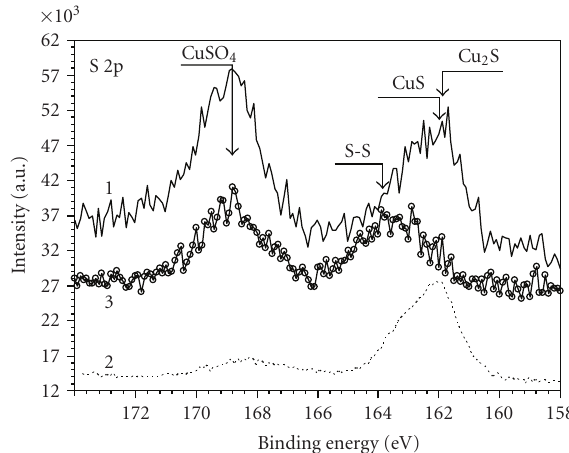
Figure 4: Sulfur XPS S 2p spectra of PA 6 sulfured for 5 hours and treated with Cu(I) salt: (1) before and (2) after Ar + cleaning, (3) sulfured PA 6 (for 4 hours at 20 ◦ C) before Cu(I) salt treatment. Arrows show possible positions of sulfur peaks as described in the